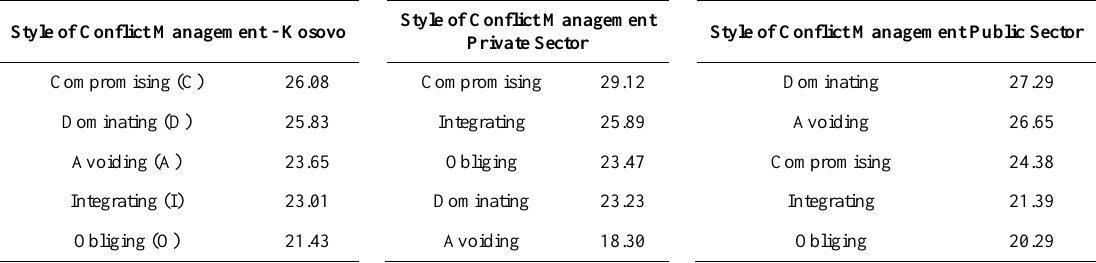
Table 4. Conflict management styles by